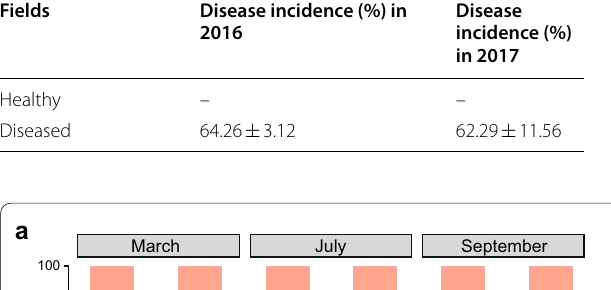
Table 2 Two-year tobacco bacterial wilt disease incidence of collection fields (mean Fields